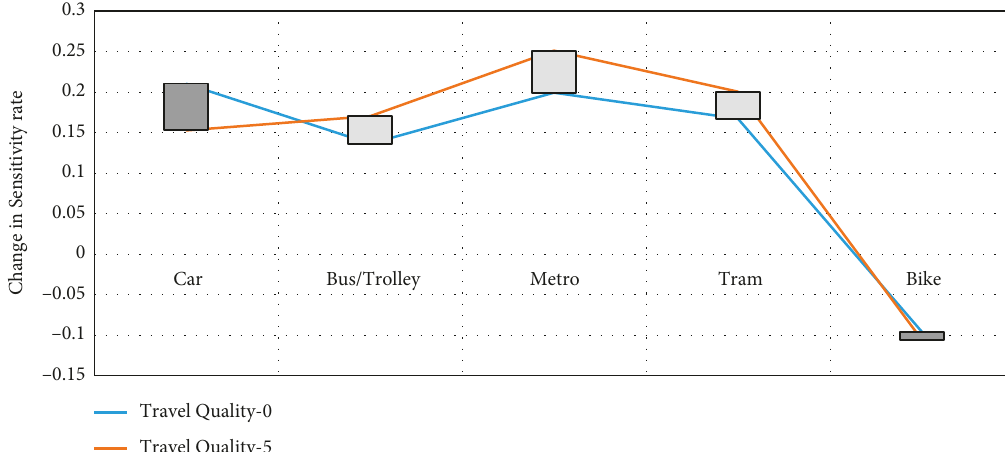
Figure 8: A comparison between the coefficients of the mode choice based on changing travel